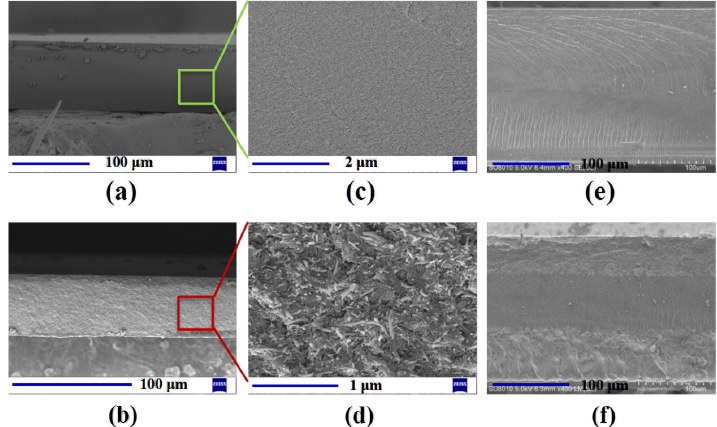
Figure 4. Cross ‐ section SEM images of the membranes. ( a ) Pure Nafion layer; ( b ) SCNT/Nafion hybrid layer; ( c ) magnification level of pure Nafion layer; ( d ) magnification level of SCNT/Nafion hybrid layer; ( e ) pure Nafion matrix membrane after hot ‐ process; ( f ) SCNT/Nafion composite matrix membrane after hot ‐ process.